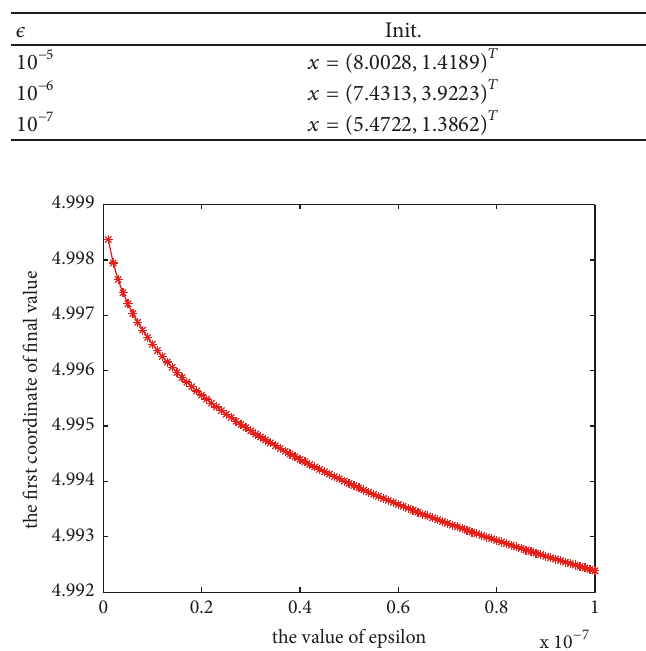
Figure 1: The behaviors of first coordinate of 𝑥 for different 𝜖 .